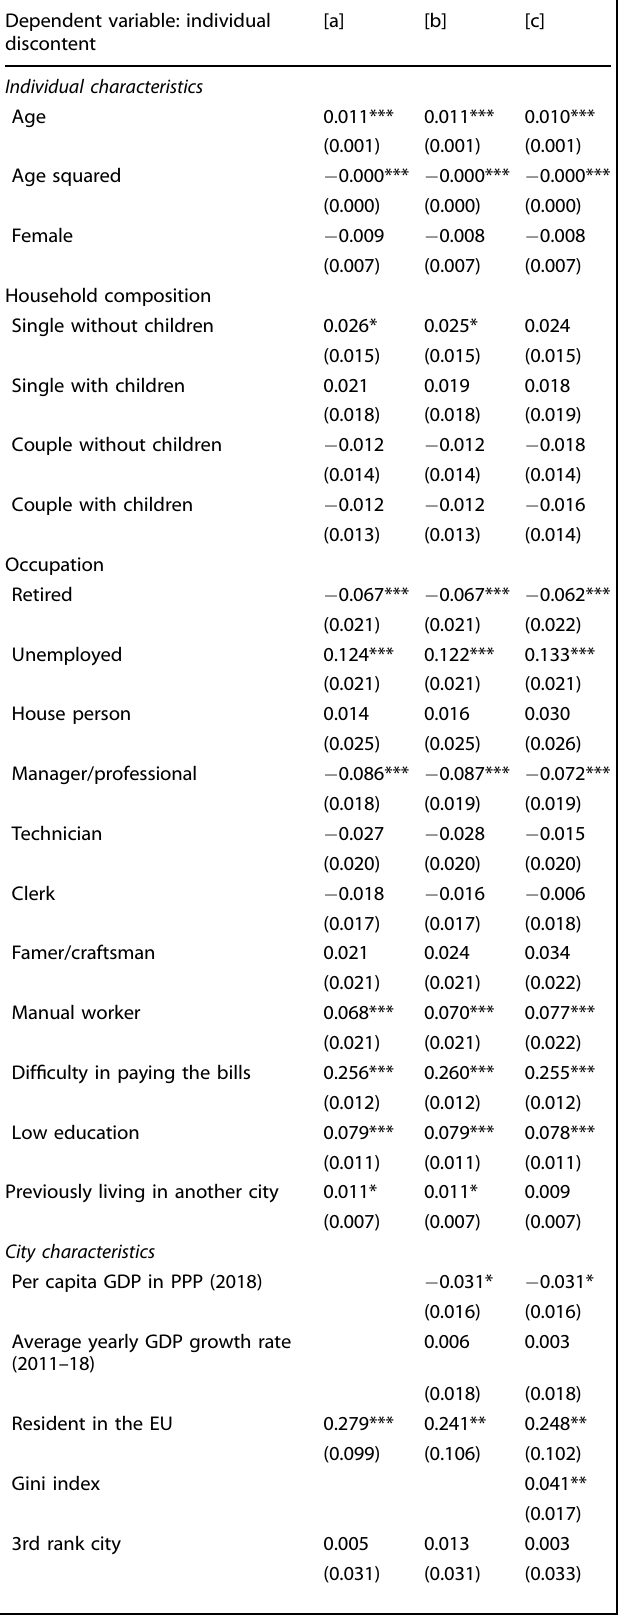
Table 2. Dissatisfaction with life as a function of individual and city